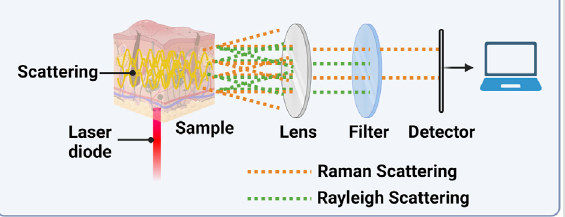
FIGURE 3 Experimental setup for a Raman spectrometer. A laser diode is focused ontothe sample and thescattered lightis collected by a lens (alternatively, the backscattered light could be collected). The Rayleighscatteredlightis then and blocked, while the Raman scattered light can be detected and its spectrum can be analysed. Created with